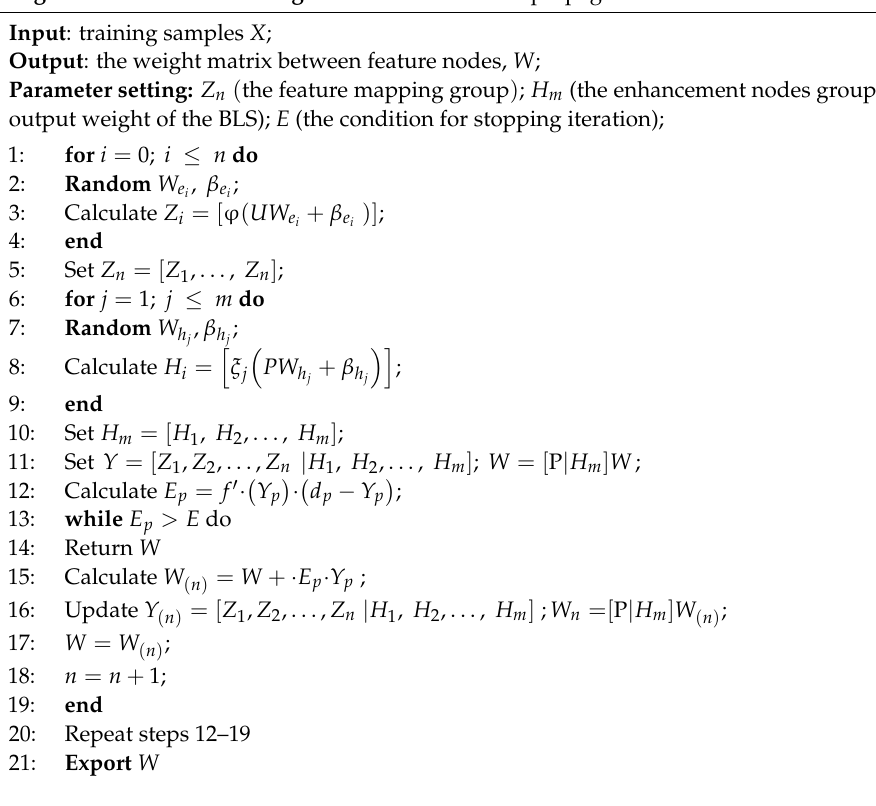
Algorithm 2: Broad Learning: Increment of the backpropagation neural network